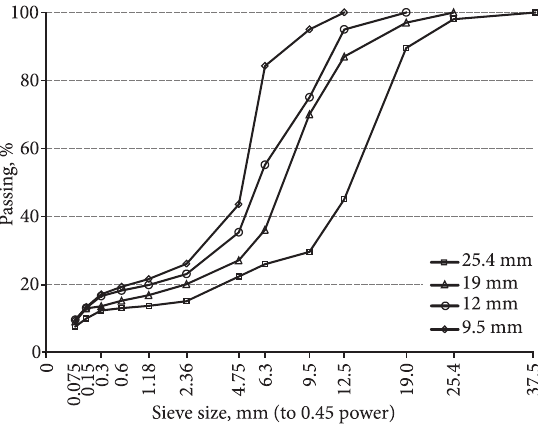
Fig. 1. Aggregate gradations with NMAS Table 1. Typical grading and bitumen content for SMA mixtures Description of properties